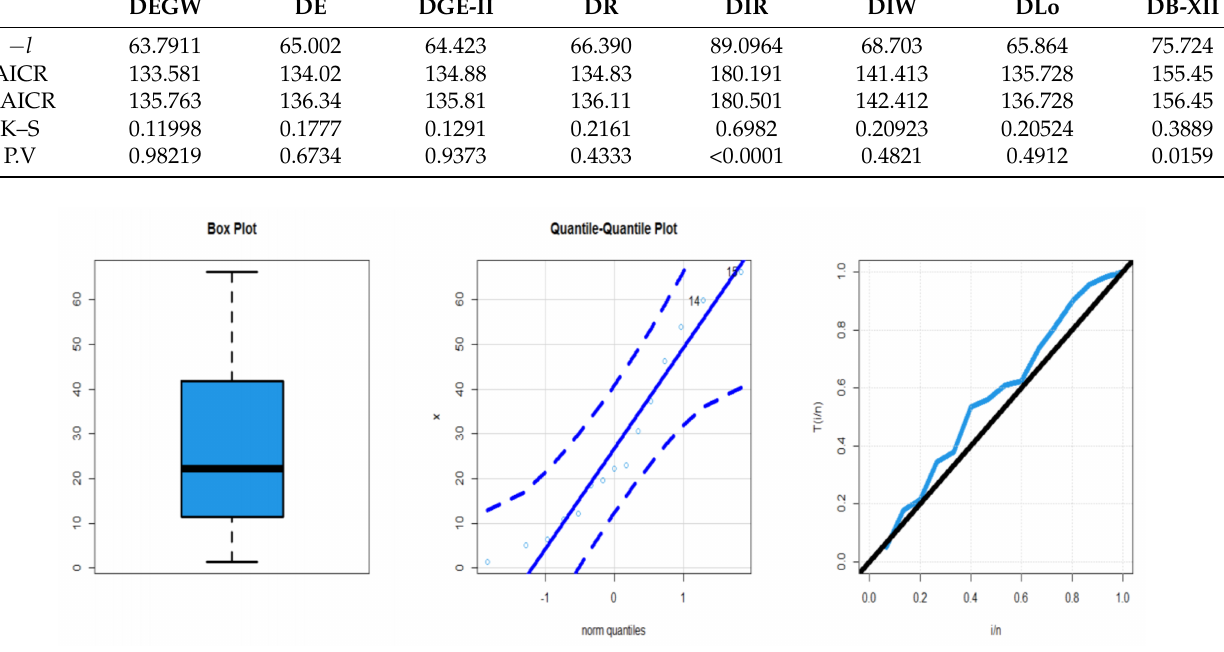
Figure 9. Boxplot, Q-Q plot, and TTT plot for dataset